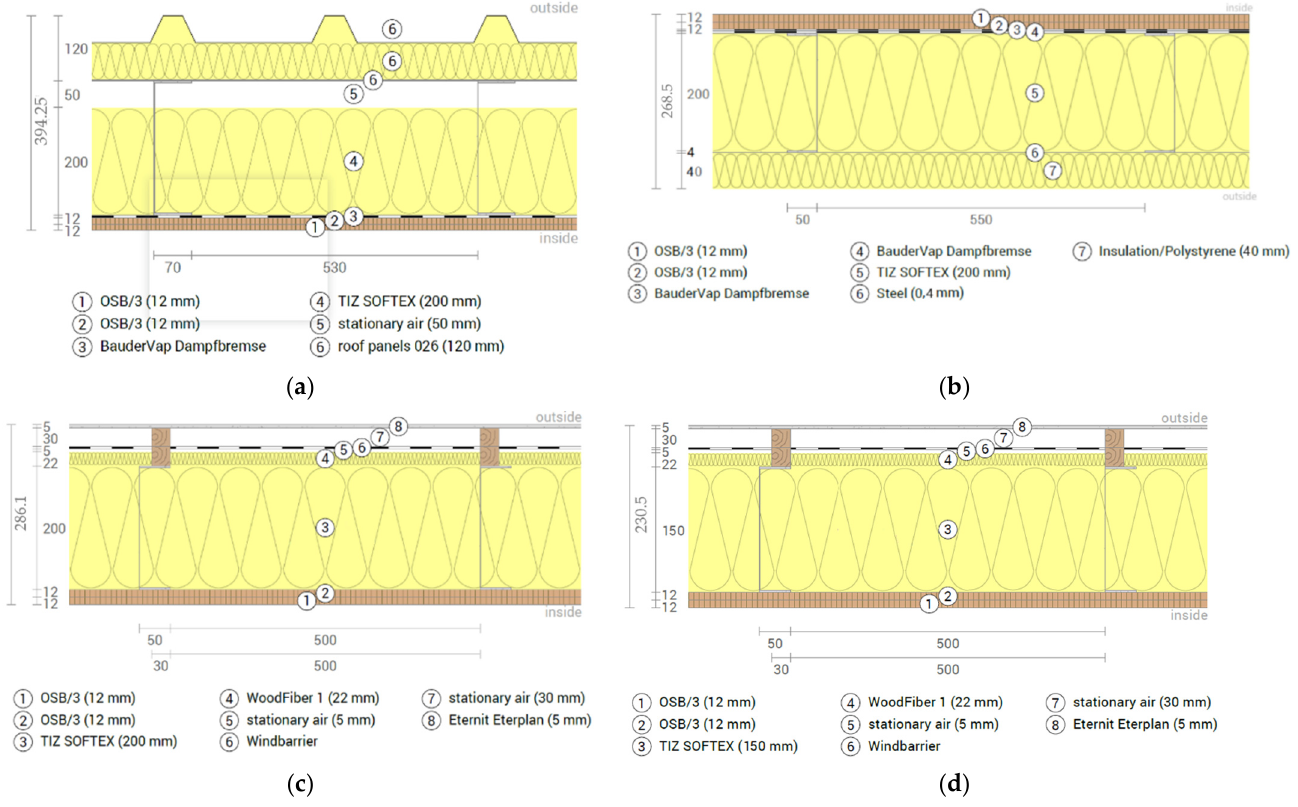
Figure 6. LSF construction elements cross section: ( a ) roof; ( b ) ground floor above crawl space; ( c ) exterior wall north; ( d ) exterior wall—east and west. Reprinted from